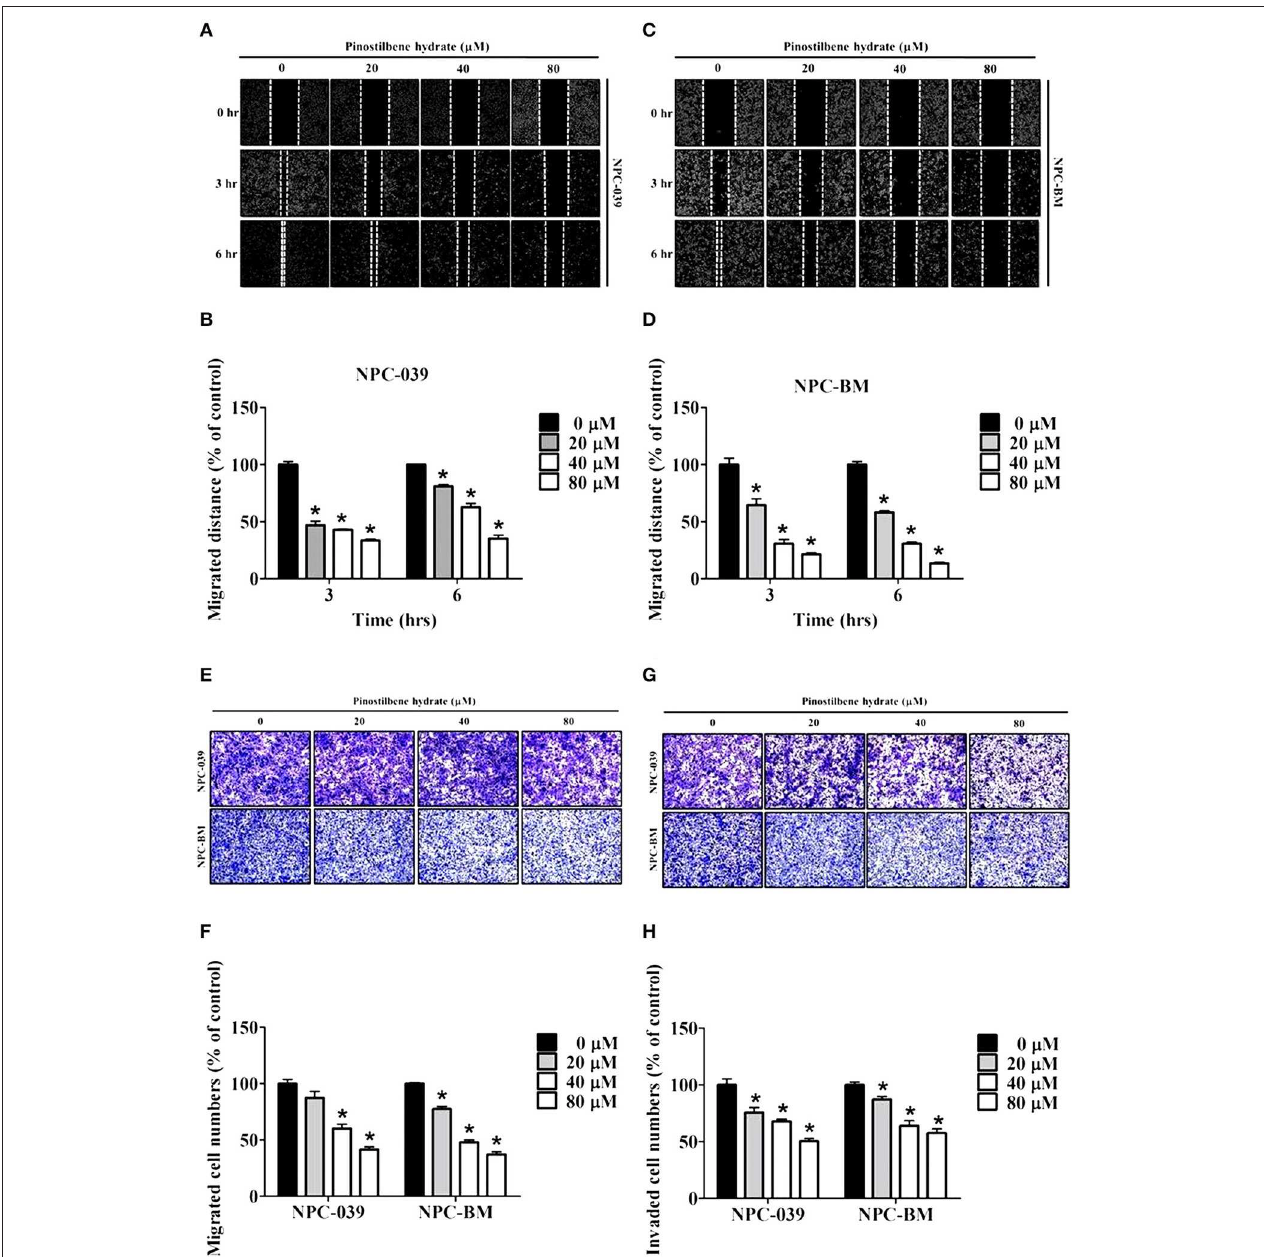
FIGURE 2 | Effects of PSH on motility, migration, and invasion of NPC cell lines. NPC cells were treated with various concentrations of PSH (0, 20, 40, and 80 µ M) for 24h. The migrated distance was determined by the wound healing assay on NPC-039 (A,B) and NPC-BM (C,D) cell lines. PSH significantly reduced the migrated distance of NPC cells when pictured at 3 and 6h in a dose-dependent manner. To evaluate the effects of PSH in migration (E,F) and invasion (G,H) transwell assays were used. The abilities of cell migration and invasion were markedly inhibited by PSH on both cell lines in a dose-dependent manner. The values are the mean ± SD of at least three independent experiments. * p <